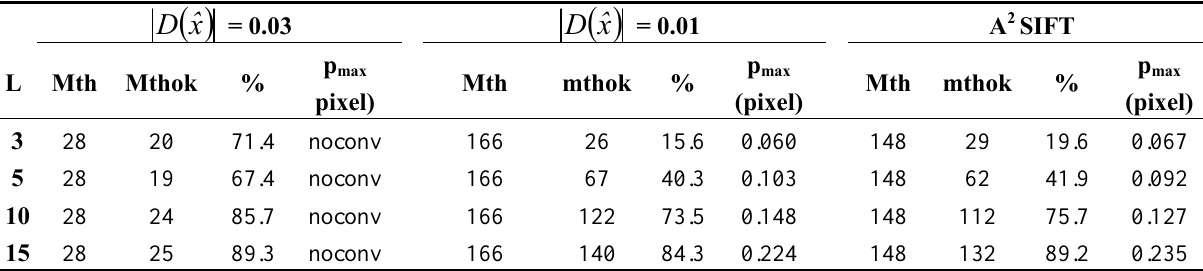
Table 8. Comparative test. Experimental results of the SIFT operator, in relation to   xˆD and L